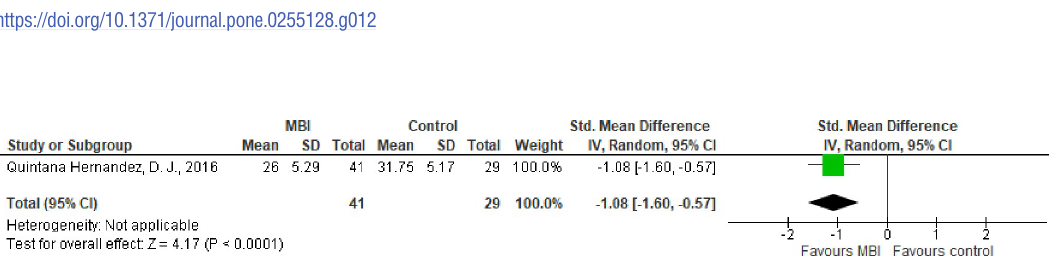
S1 Table. Summary of findings (6w-10w).